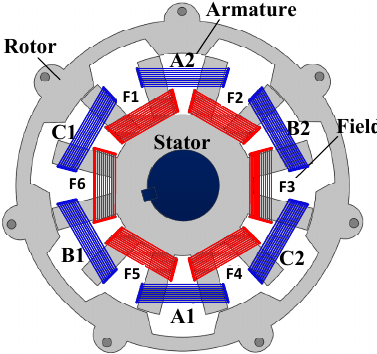
Figure 1. The structure of a flux-switching motor.